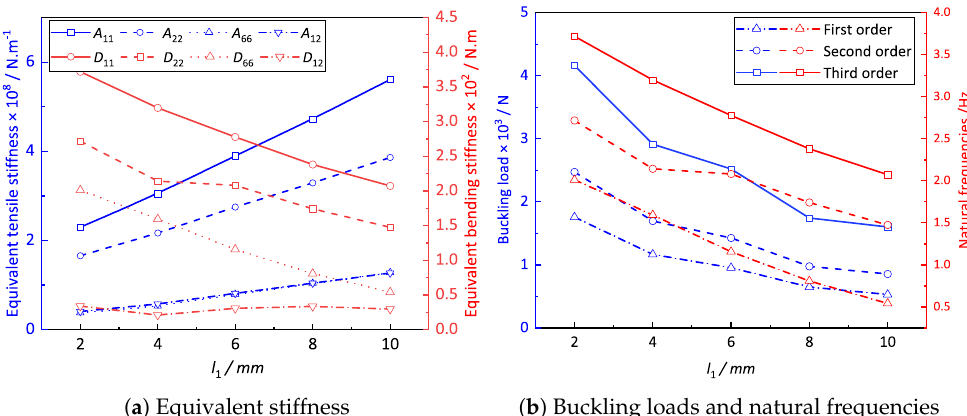
Figure 9. The influence of l 1 on the effective performance of